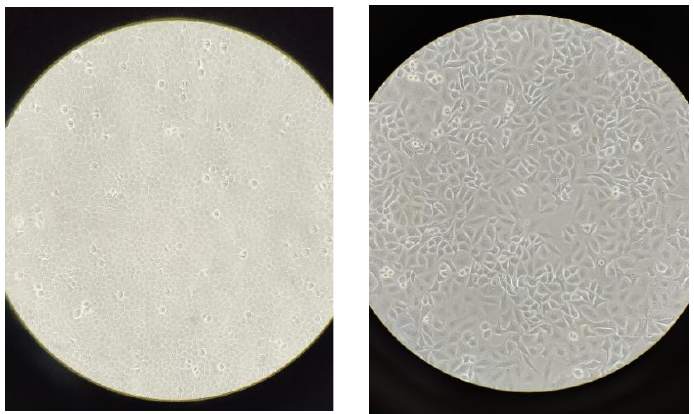
Figure 3. ( Right ) A549 cell line micrograph; ( Left ) Caco-2 cell line.